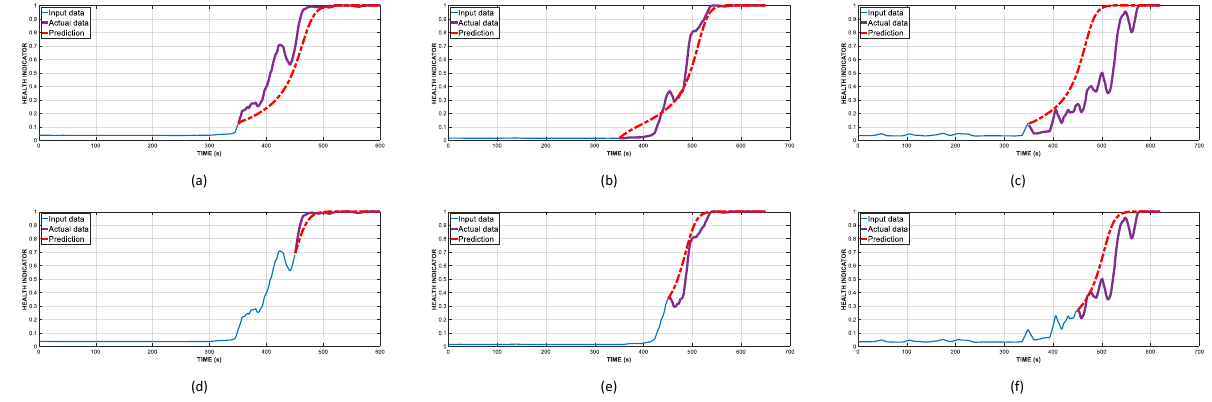
Figure 6. Prediction of future HI from the three tests at two major time steps. ( a ) Reinforced concrete beam α at the 350th time step. ( b ) Reinforced concrete beam β at the 350th time step. ( c ) Reinforced concrete beam γ tests at the 350th time step. ( d ) Reinforced concrete beam α at the 450th time step. ( e ) Reinforced concrete beam β at the 450th time step. ( f ) Reinforced concrete beam γ at the 450th time step.